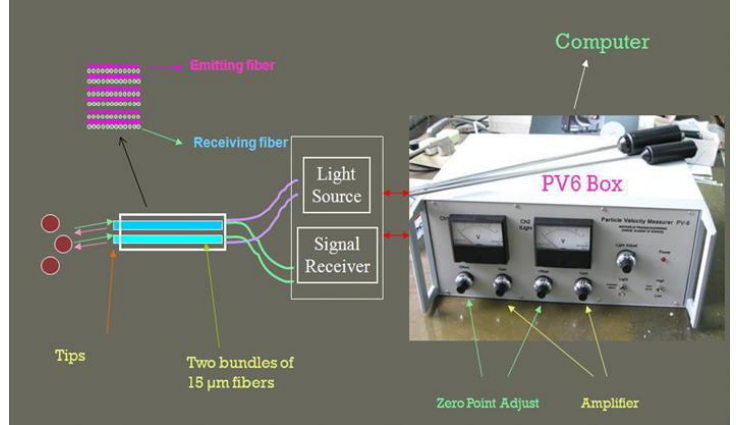
Figure 7. Electronics of the developed optical probe (PV6) used in the present study for velocity and solids concentration measurements (Institute of Process Engineering of the Chinese Academy of Sciences).